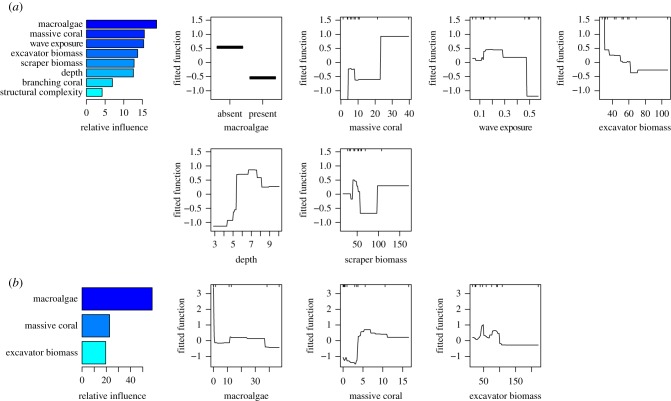
Relative influence (leftmost column) and partial dependency plots (for variables more than 10% relative influence) for the most influential variables in the boosted regression tree analysis for each set of ecological predictors. Predicting from (a) pre-bleaching (1994) and (b) post-bleaching (2005) ecological conditions. (Online version in colour.)